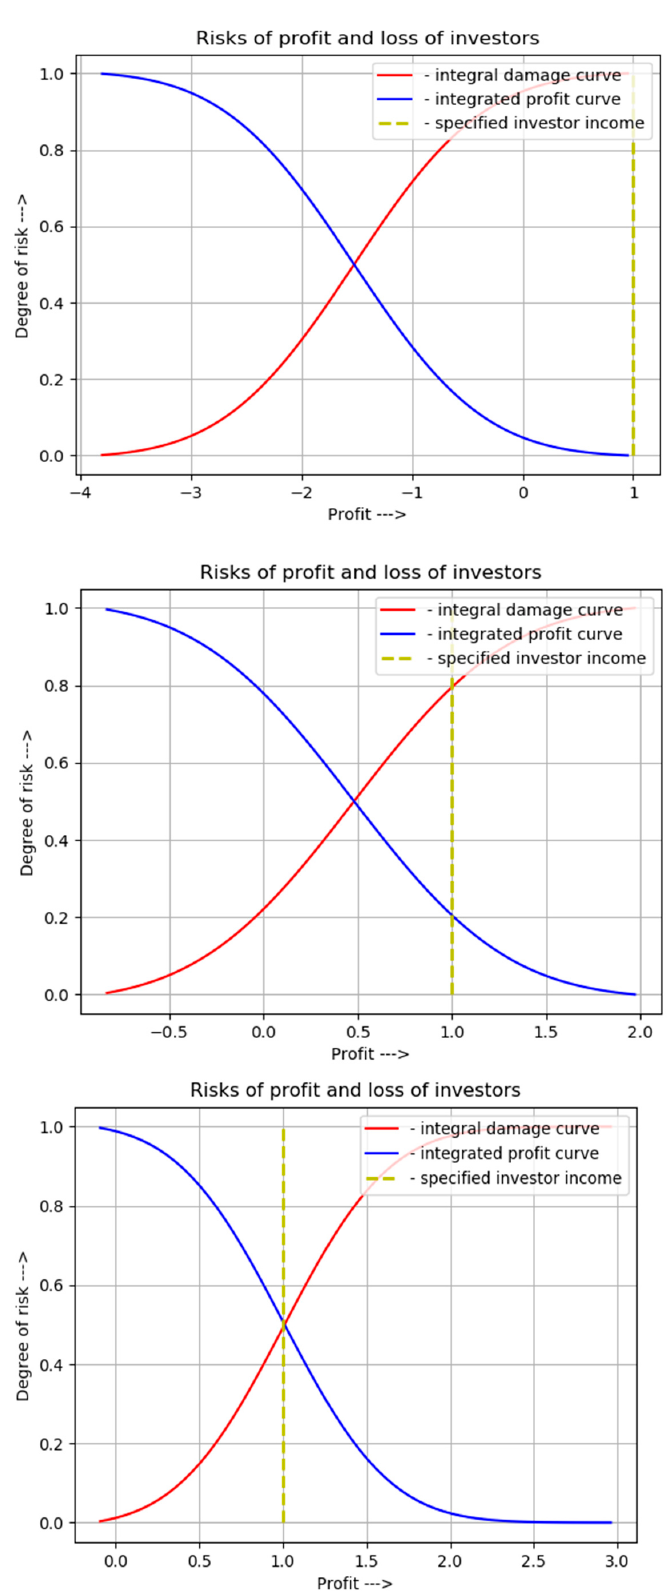
Figure 5. The integrated curves of profit ( P r ) and loss ( P l ) for investors in biohydrogen production projects from agricultural raw materials, taking into account their requirements (the minimum profit of investors— P s = 1 $/kg).